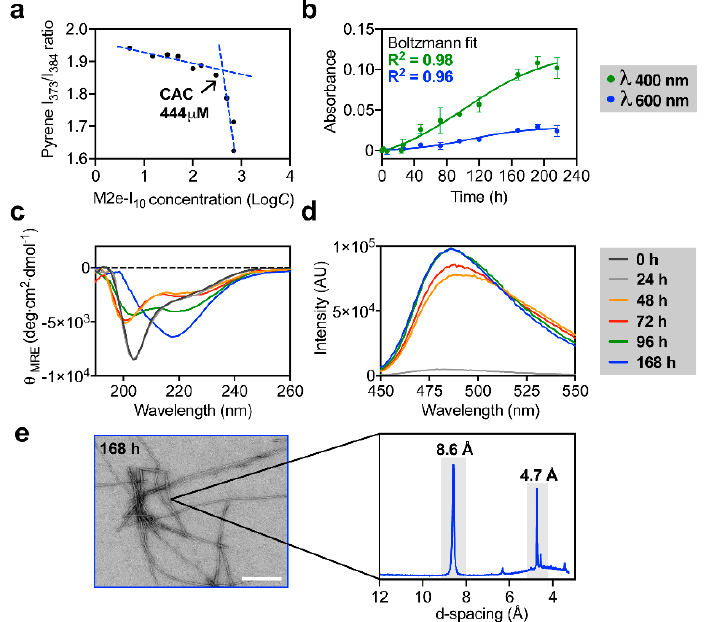
Figure 2. Biophysical characterization of the self-assembly of M2e-I 10 into fibrils. ( a ) Determination of critical aggregation concentration (CAC) by plotting the pyrene I 373 / I 384 fluorescence ratio vs. M2e-I 10 concentration. ( b ) Absorbance measurement over time of self-assembly of M2e-I 10 . Raw data and non-linear Boltzmann fit are presented. ( c , d ) Kinetics of self-assembly of M2e-I 10 measured by far-UV circular dichroism (CD) spectroscopy and ( d ) ThT fluorescence, with excitation at 440 nm. ( e ) Representative TEM image of M2e-I 10 assembled for 168 h (left panel) and diffraction pattern obtained by powder X-ray diffraction (PXRD) (right panel).